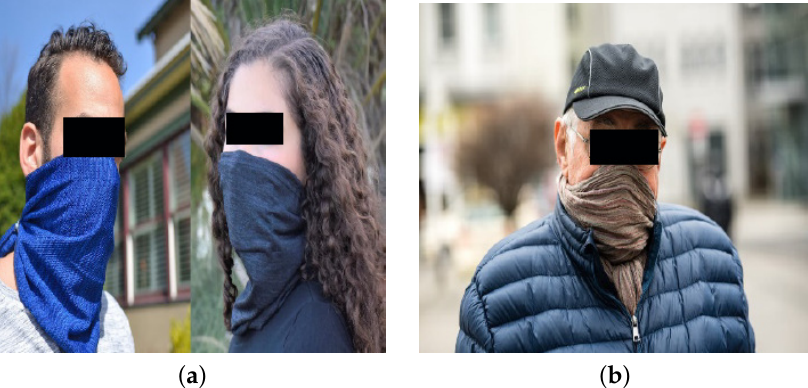
Figure 2. Images in Mask category, containing faces that wear ( a ) neckband and ( b ) scarf instead of a